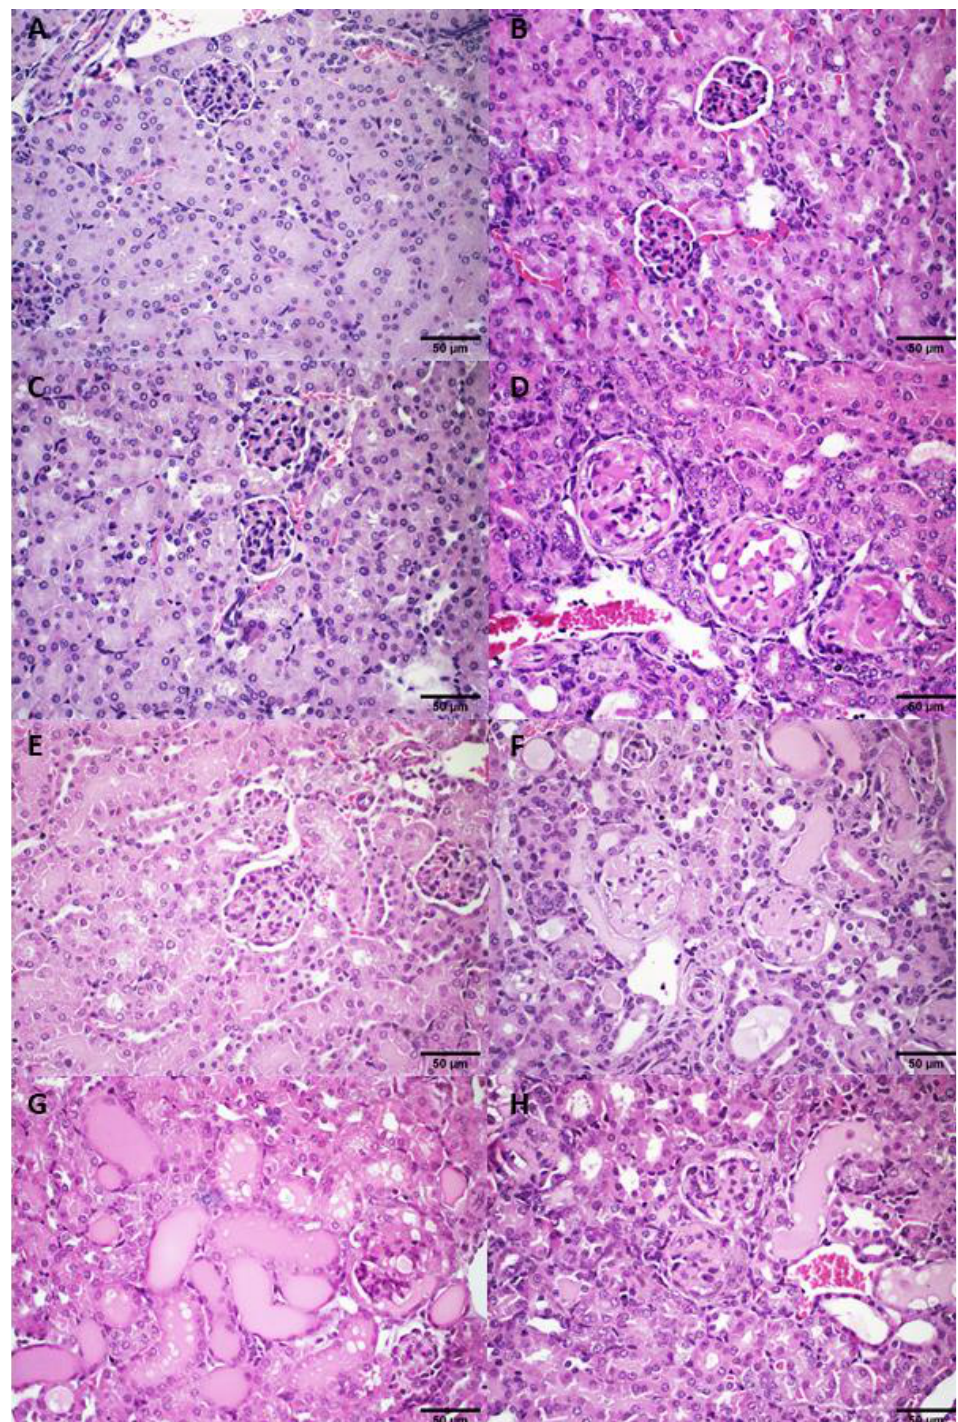
Figure A5. Histological sections of female Balb/c mice kidney. ( A ) Control group (HBS), ( B ) ExoSpHL, and ( C ) SpHL-DOX at a dose of 15 mg/kg, ( D ) ExoSpHL-DOX at a dose of 15 mg/kg, ( E ) ExoSpHL-DOX at a dose of 17.5 mg/kg, ( F ) DOX at a dose of 10 mg/kg, ( G ) DOX at a dose of 12.5 mg/kg, ( H ) SpHL-DOX at a dose of 17.5 mg/kg.